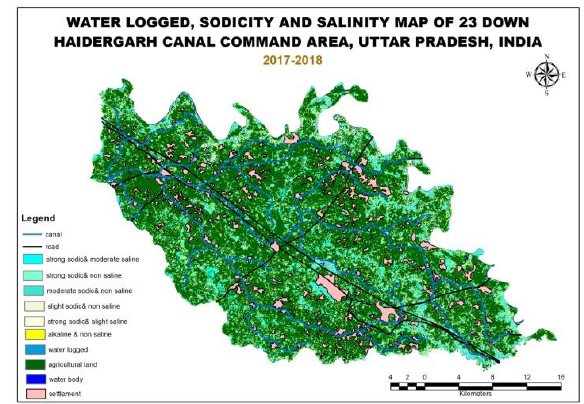
Figure 11: Land use categories by Digitization for the year 2017-2018